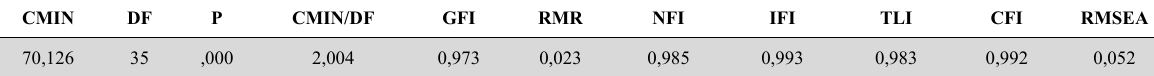
CFA Results of Organizational Cynicism Scale